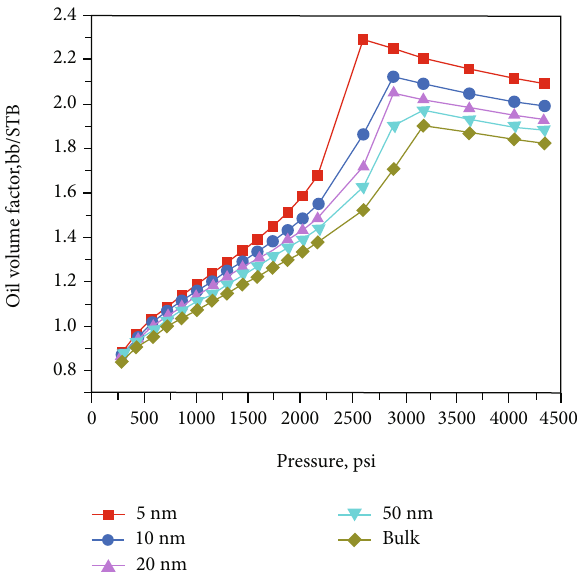
Figure 15: Oil viscosity of the Bakken tight oil versus pressure at various pore radii at T = 230 °